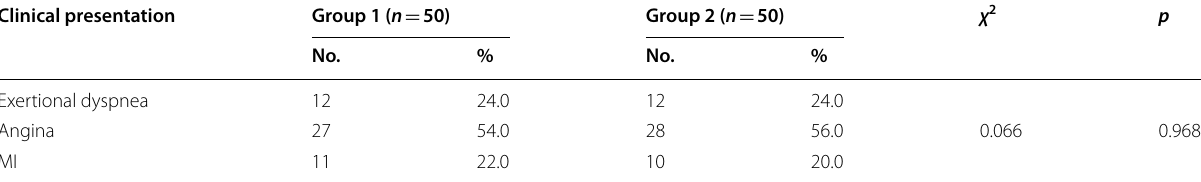
χ 2 Chi-square test, p p -value for comparison between the two studied groups, Group 1 patient treated with PCI and drug-eluting stents, Group 2 patient treated with CABG